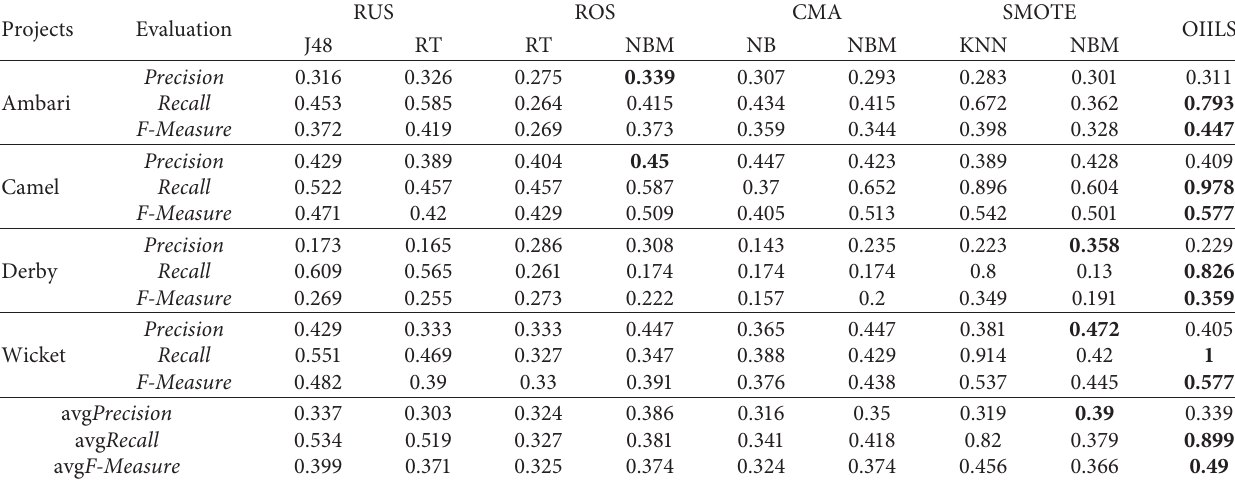
Table 7: The prediction results of OIILS and 4 combinations.